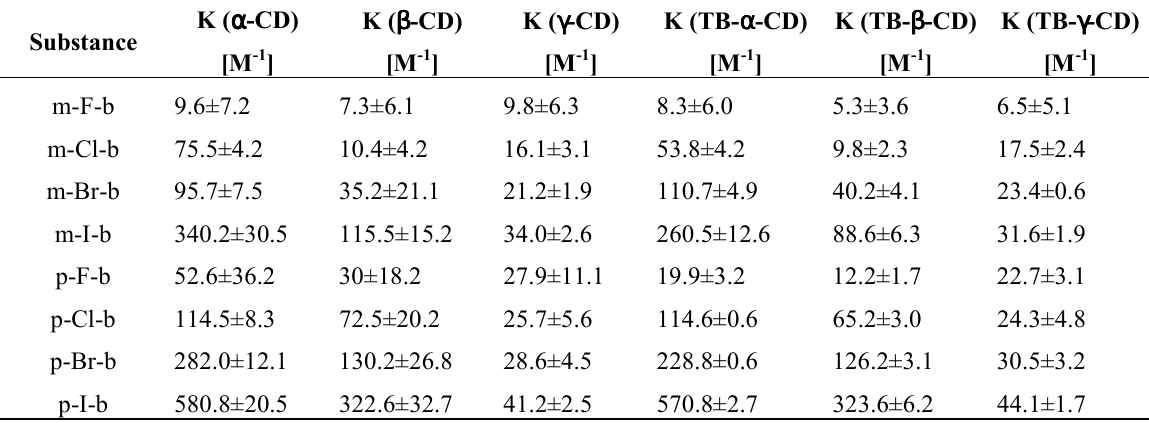
Table 3. Association constants for 1:1 inclusion complexation of benzoic